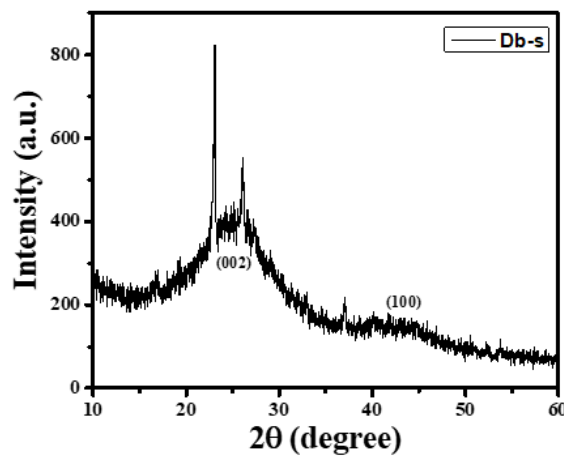
Figure 2. XRD pattern of AC